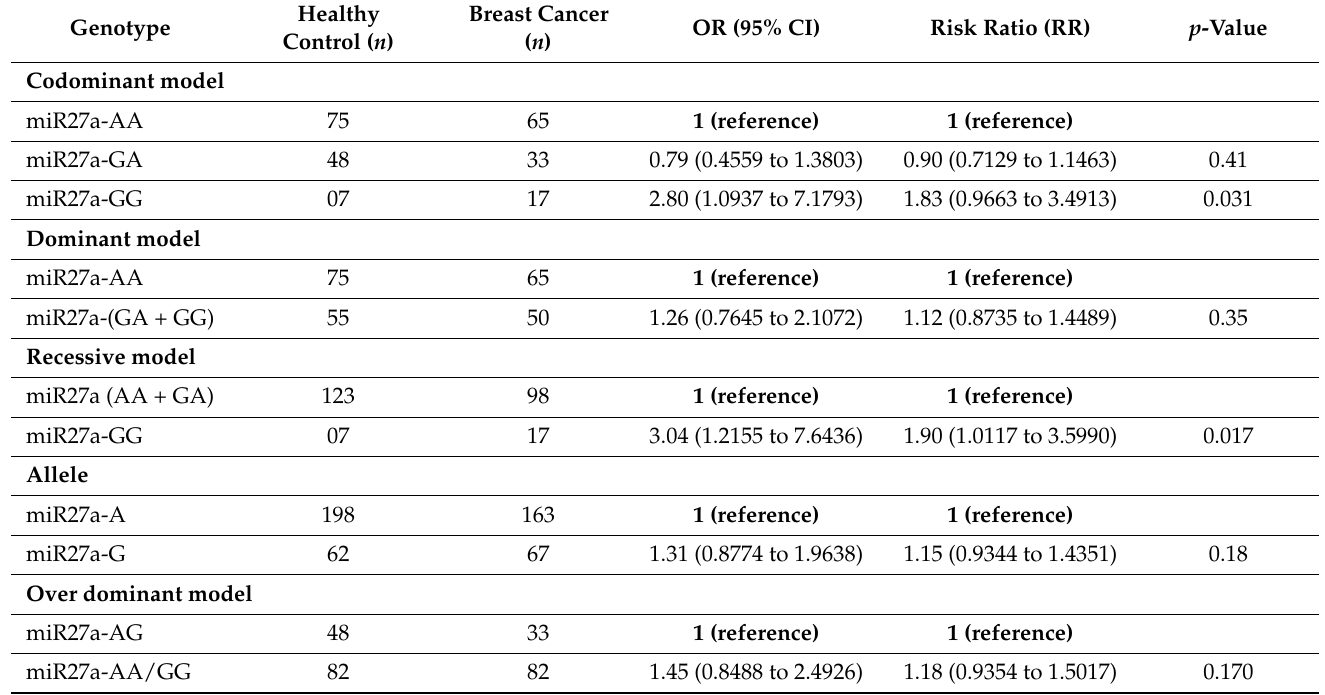
Table 8. Risk of breast cases with respect miRNAs 27a rs895819 A > G